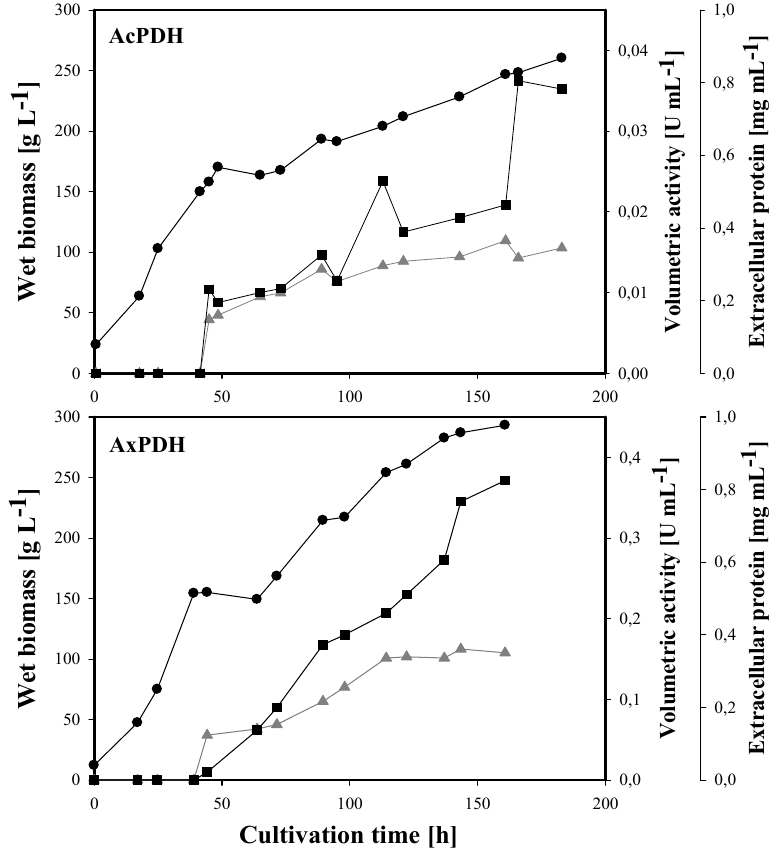
Figure 1. Large scale production of pyranose dehydrogenases (PDHs) in P. pastoris . Black circles, wet biomass; grey triangles, extracellular protein concentration; black squares, volumetric